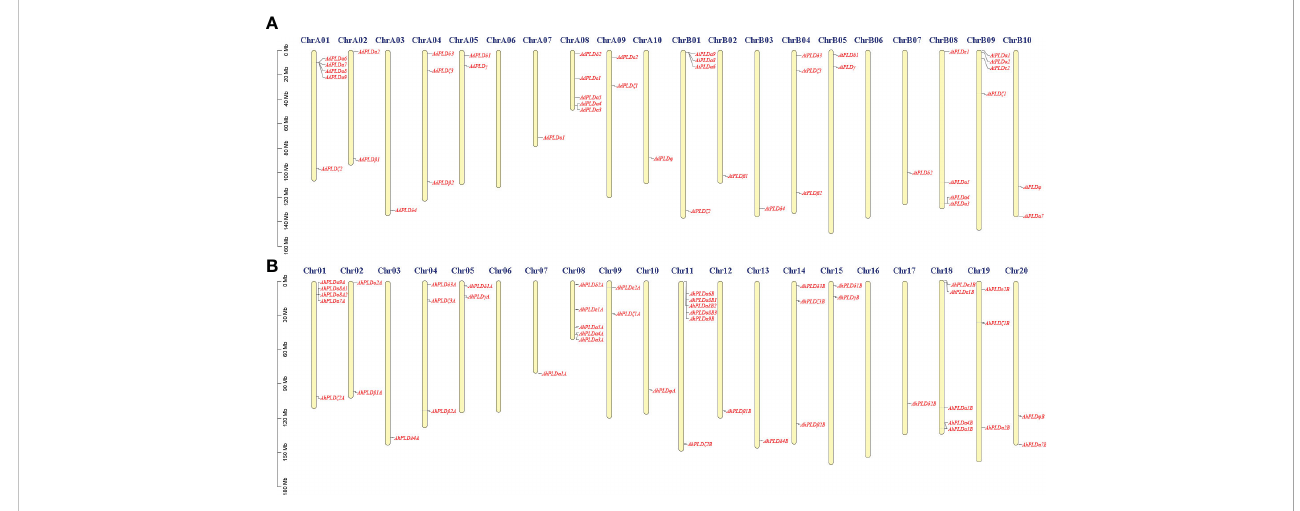
FIGURE 1 Chromosomal distribution of Arachis PLD genes. (A) Chromosomal distribution of PLD genes in A . duranensis and A . ipaensis . (B) Chromosomal distribution of PLD genes in A . hypogaea . Yellow color bars represent the chromosomes, and the location of PLD genes has been marked alongside.